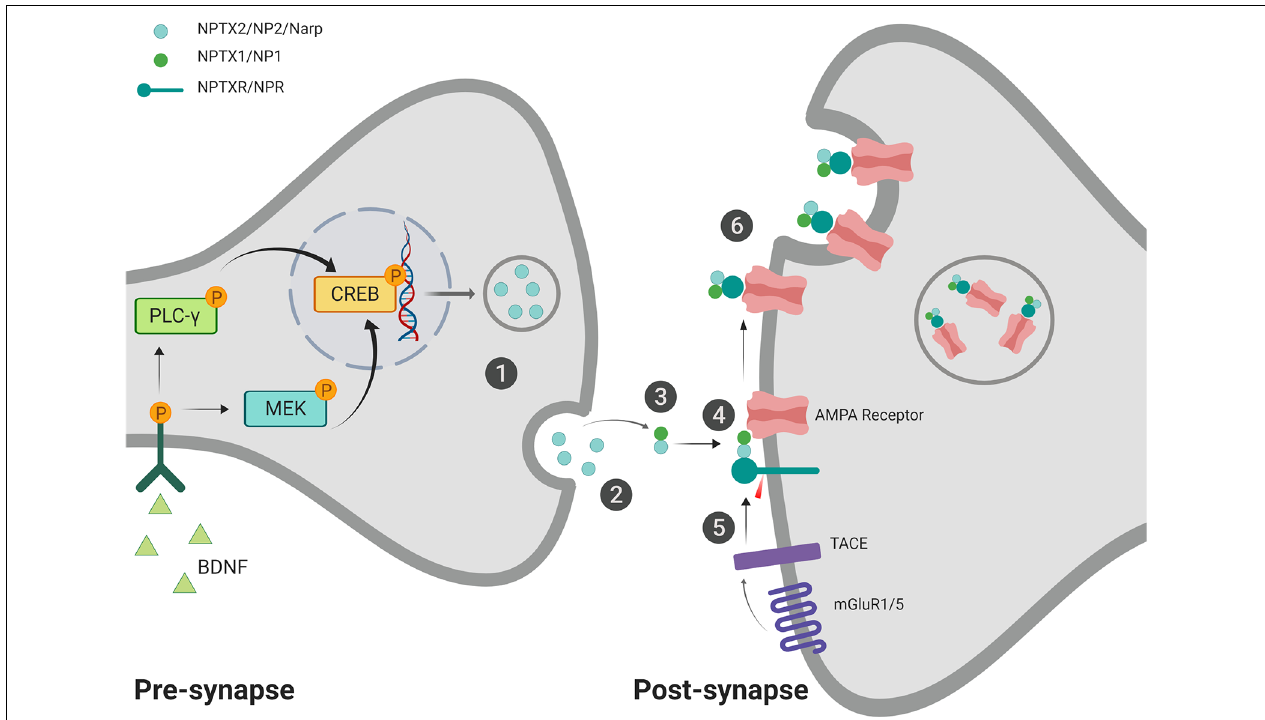
FIGURE 1 | Proposed mechanism for neuronal pentraxin 2 (NP2)-facilitated α -amino-3-hydroxy-5-methylisoxazole-4-propionic acid (AMPA) receptor aggregation. (1) Pentameric NP2 is released from the pre-synaptic cell in response to neuronal activity/seizure (Tsui et al., 1996) or brain-derived neurotrophic factor (BDNF) induction (Mariga et al., 2015). (2) NP2 makes its way to the post-synaptic membrane, possibly facilitated via perineuronal nets (van’t Spijker and Kwok, 2017). NP2 may be maintained at the membrane through PNN interaction (not shown; Chang et al., 2010). (3) NP2 can form a complex with NP1 at the